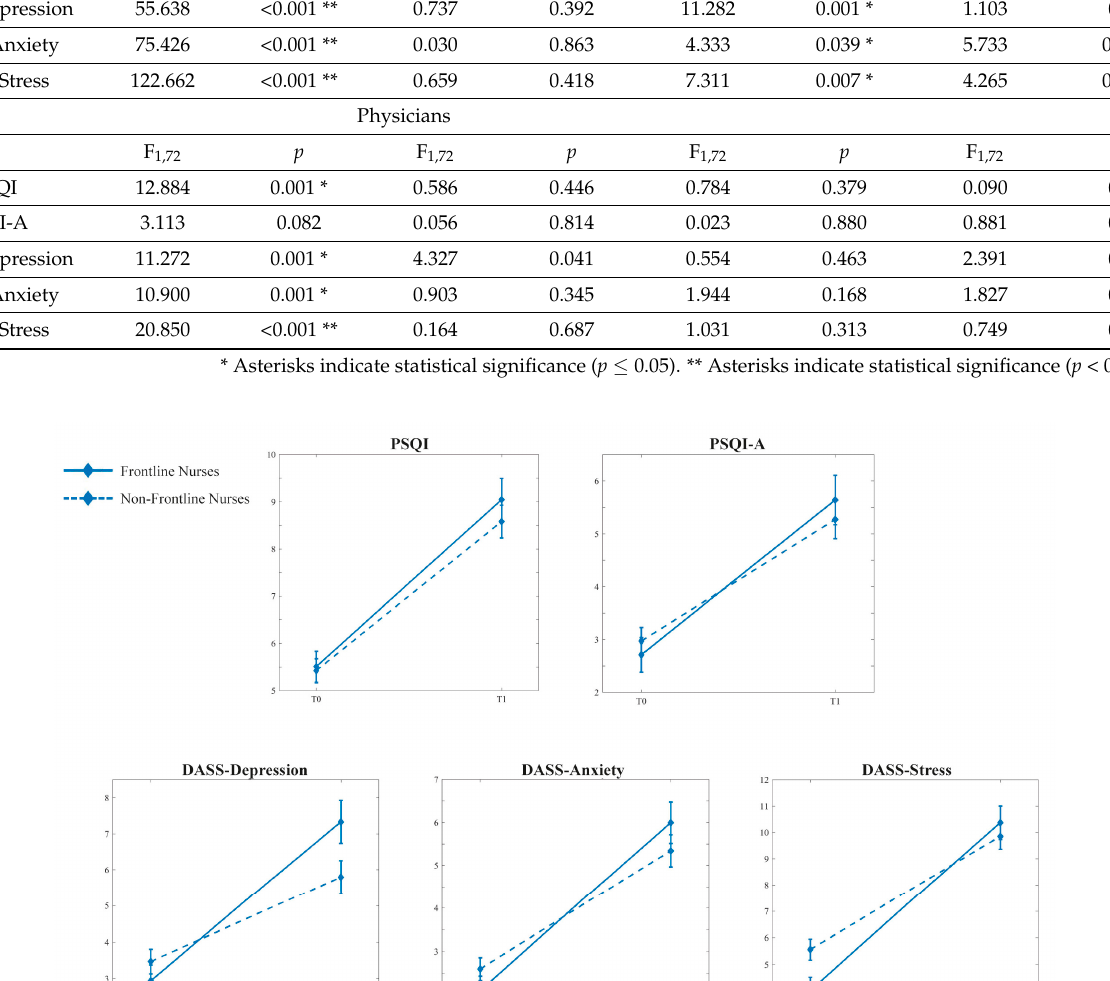
Figure 3. Mean (and SE) across the two time periods (T0: before the pandemic; T1: current period) among frontline (n = 80) and non-frontline (n = 132) nurses working for the following variables: total scores of Pittsburgh Sleep Quality Index (PSQI), total scores Pittsburgh Sleep Quality Index- Addendum (PSQI-A), scores on each scale of Depression Anxiety Stress Scale (DASS-21).